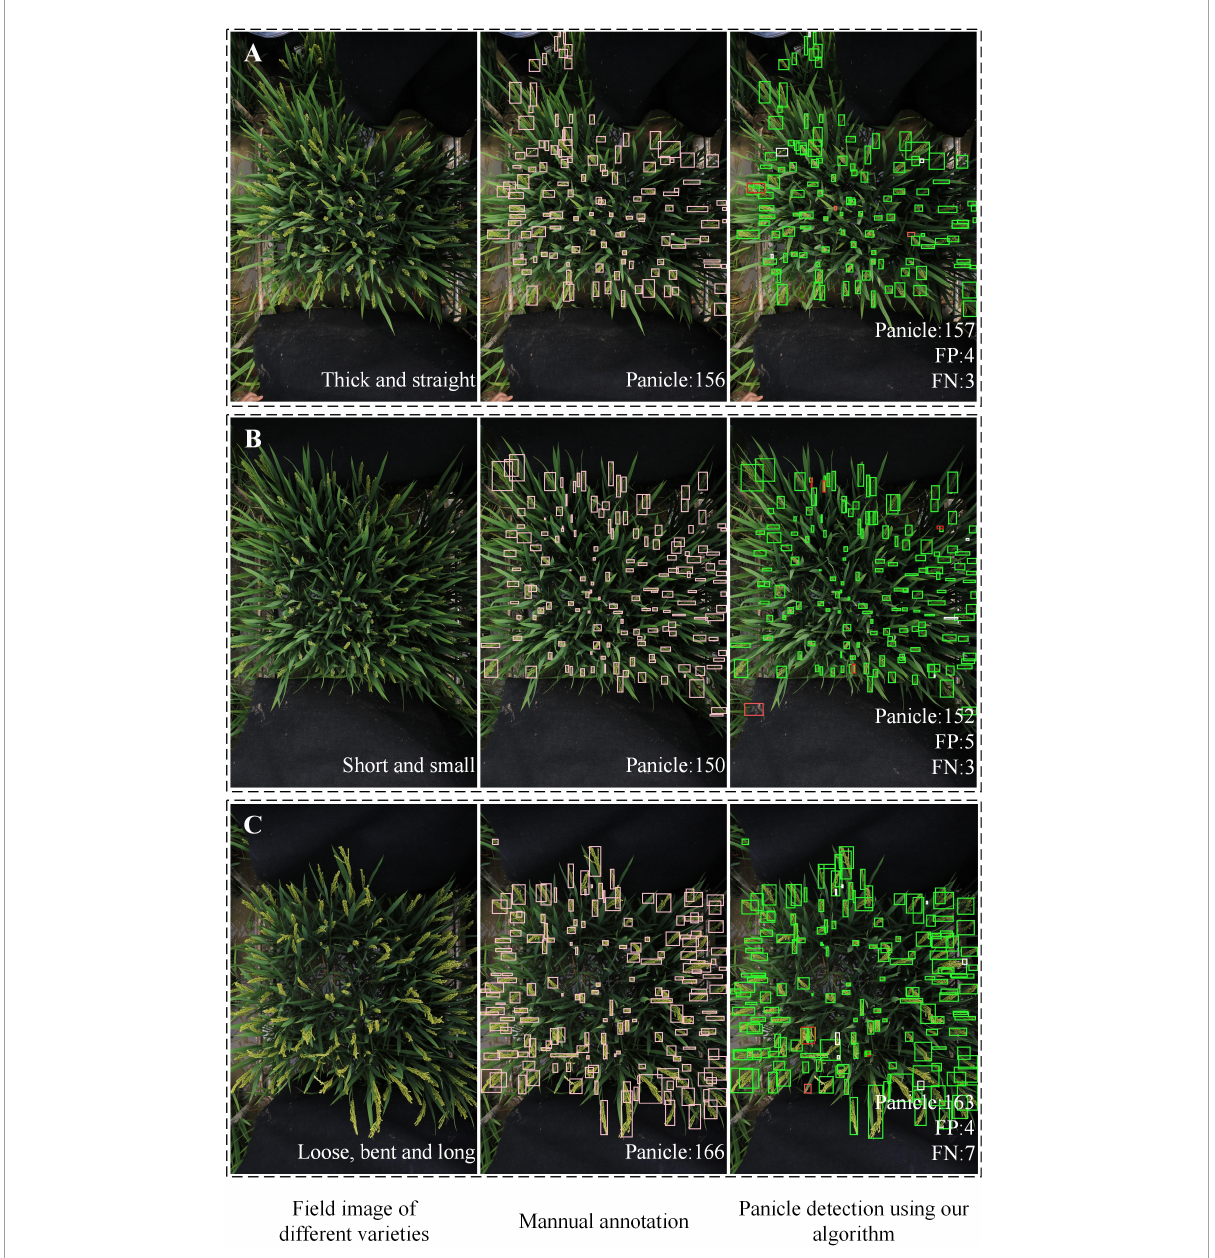
FIGURE8 Examples of rice field images with different rice accessions. (A) Thick and straight. (B) Short and small. (C) Loose, bent and long. In the detection results, green boxes are correct bounding boxes; white boxes are FN boxes; red boxes are FP